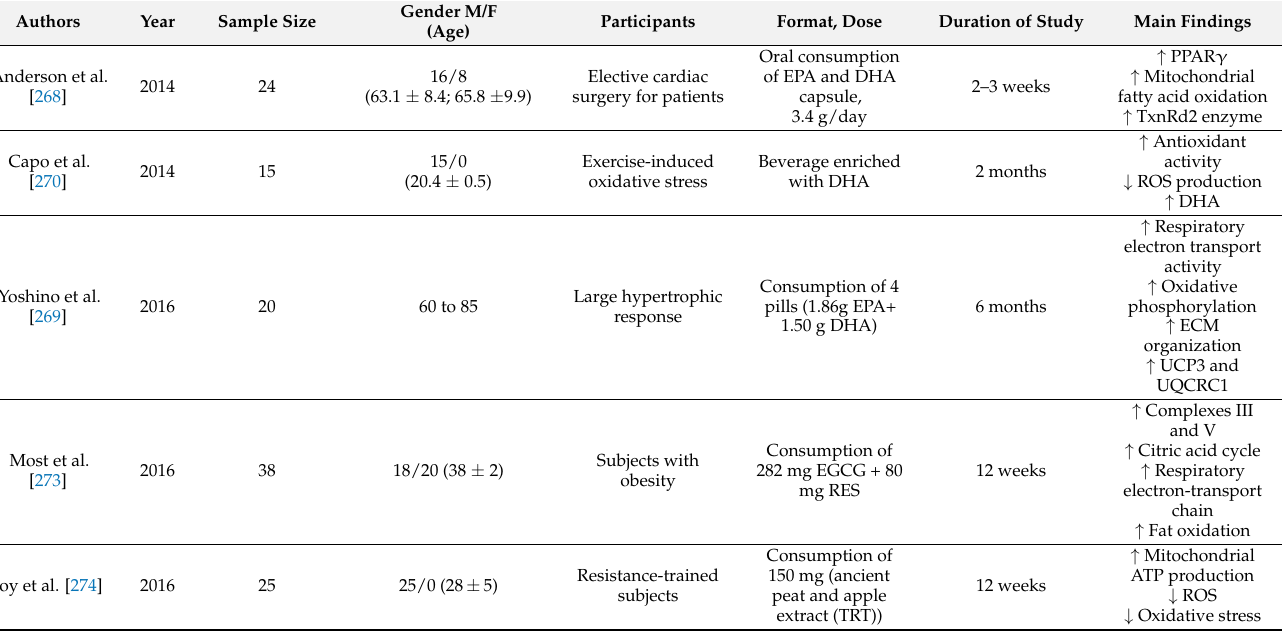
Table 4. Clinical studies in metabolic syndrome assessing the efficacy of MD components on